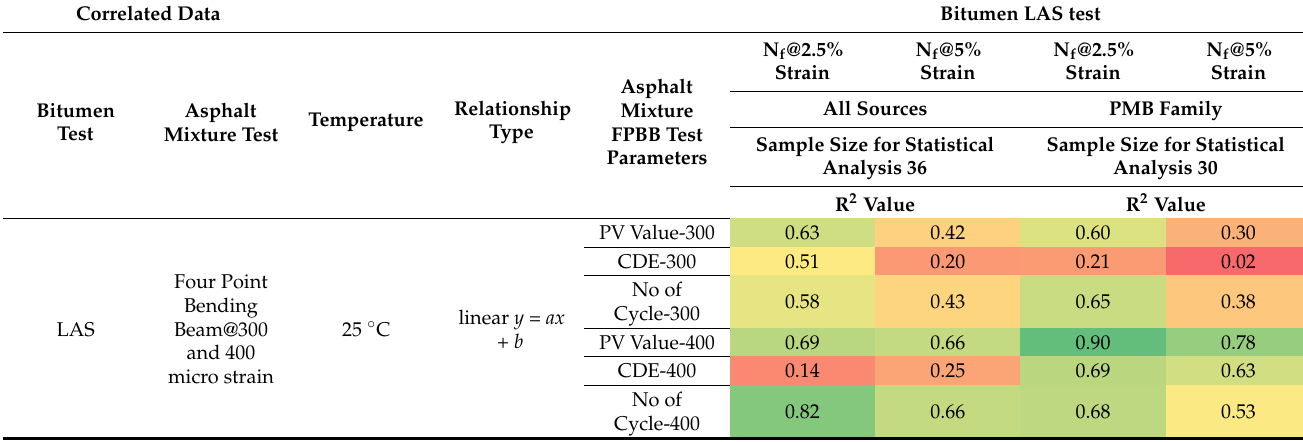
Table 11. Pearson coefficients of determinations between asphalt binders and mixtures for FPBBT; (Green Background = Moderate to High Correlation (Darker Green = Higher Correlation Compared to Lighter Green); Yellow Backgound = Average Correlation; Red Background = Poor